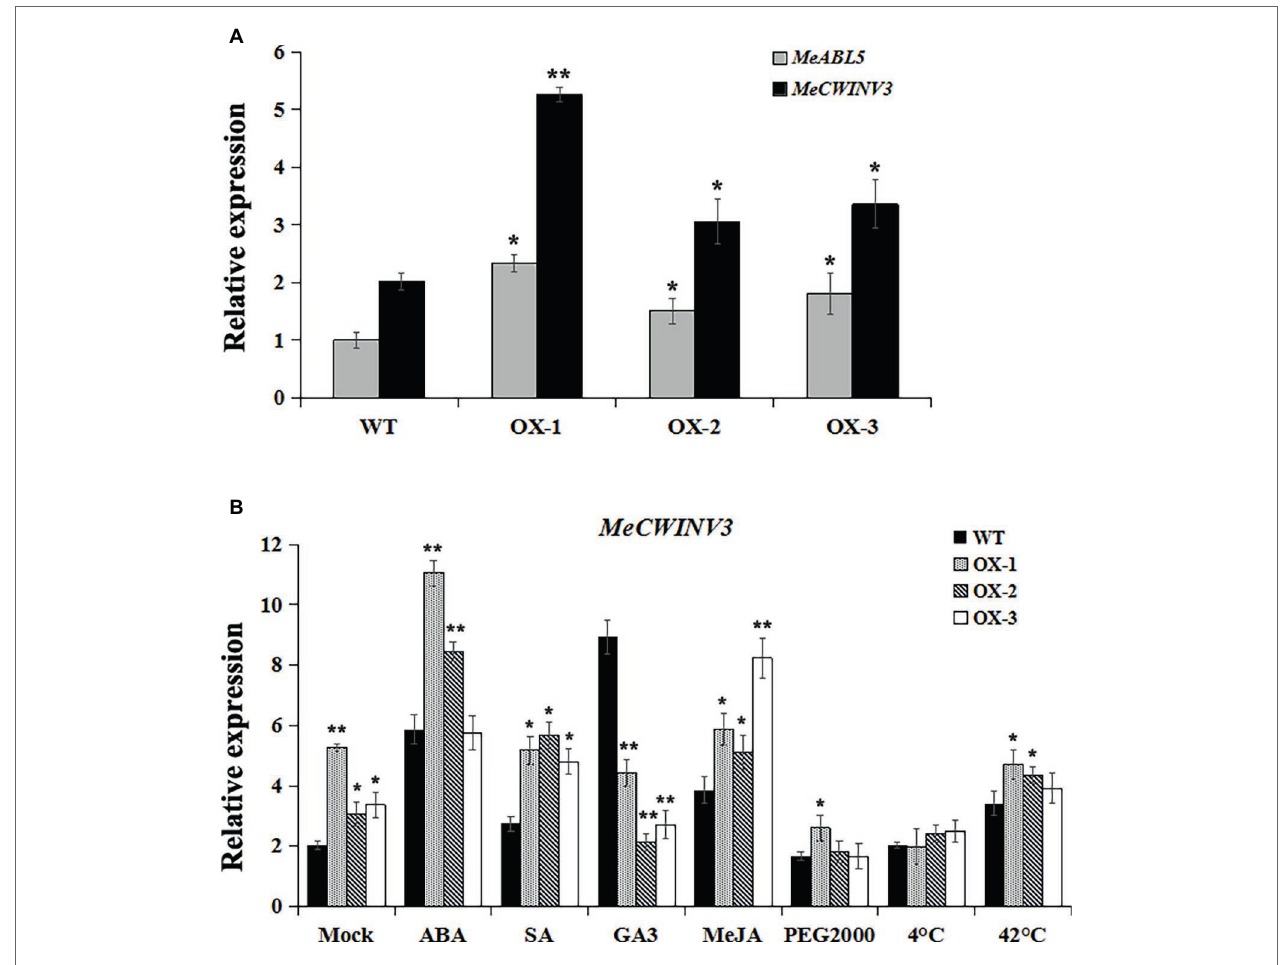
FIGURE 10 | Regulation of the MeCWINV3 expression by MeABL5 in the overexpressing transgenic cassava FECs. (A) Expression analyses of MeABL5 and MeCWINV3 in the MeABL5-OX transgenic cassava FECs using qRT-PCR. Three independent transformation experiments were performed. The expression of MeABL5 in the untransformed cassava wild-type SC8 FECs (WT) was used as a calibrator. (B) Expression analyses of MeCWINV3 in the MeABL5-OX transgenic FECs under ABA, SA, GA3, MeJA, PEG2000, cold (4°C), or heat (42°C) treatment. The WT and MeABL5-OX transgenic FECs under different treatments for 12 h were used for the analyses. WT cassava SC8 FECs were used as control. The data are presented as the mean ± SE values ( n = 3) from three independent experiments. Asterisks indicate statistically significant differences compared with WT. * p < 0.05; ** p <